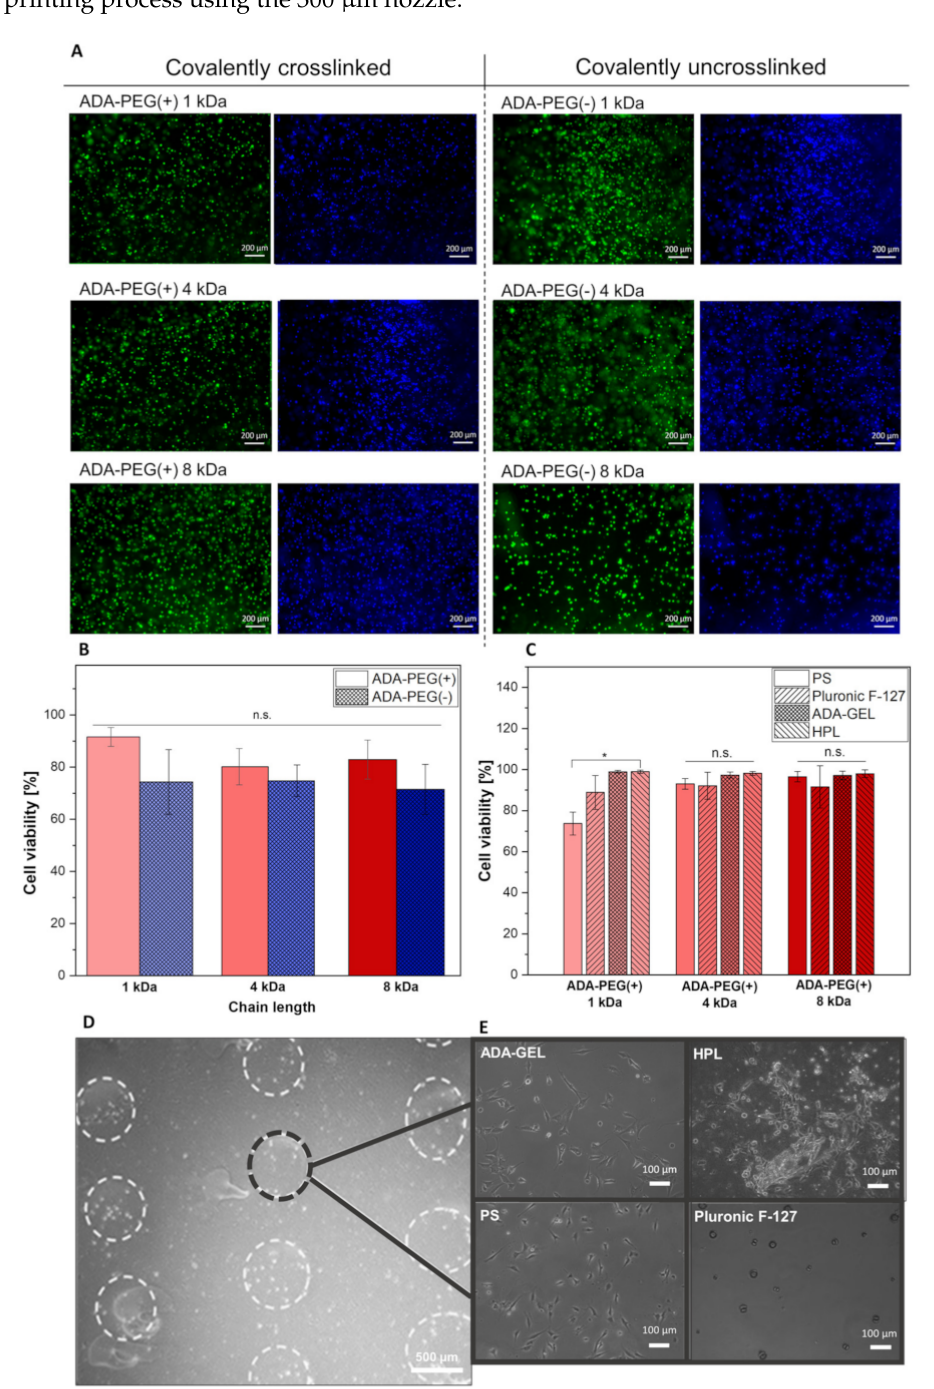
Figure 7. ( A ) Fluorescence images of NIH/3T3 cells embedded in covalently crosslinked (+) and uncrosslinked (-) ADA-PEG (1–8 kDa) bioinks stained with Calcein AM (green) and DAPI (blue); ( B ) cell viability of NIH/3T3 cells in covalently crosslinked (+) and uncrosslinked (-) ADA-PEG (1–8 kDa)